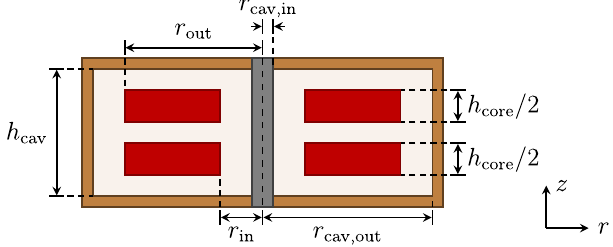
FIG. 3. Simplified two-dimensional sectional view through the center of the cavity. The dimensions of the cavity and the ring cores are given in Table II.